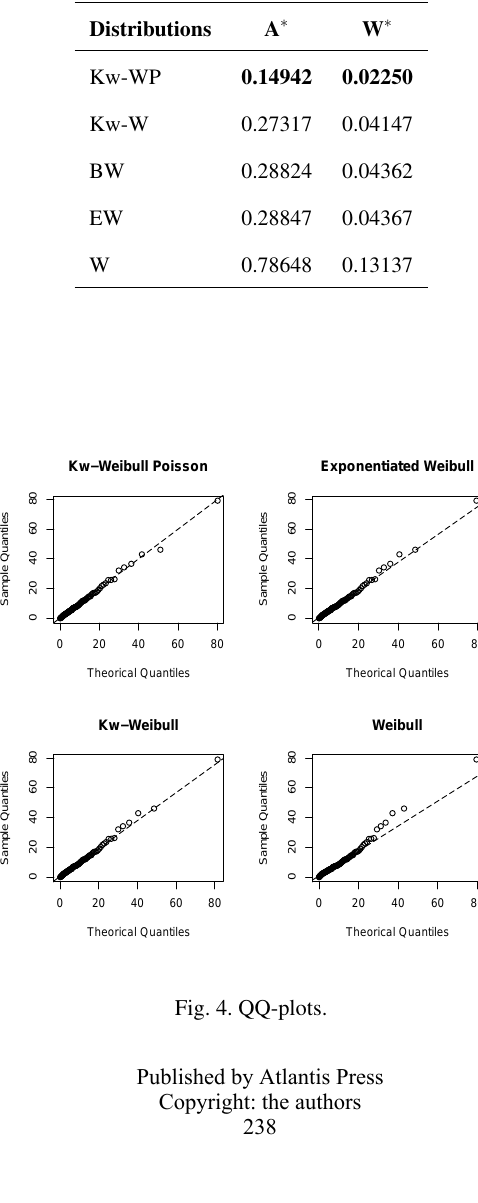
Table 2. Statistics A ∗ and W ∗ .